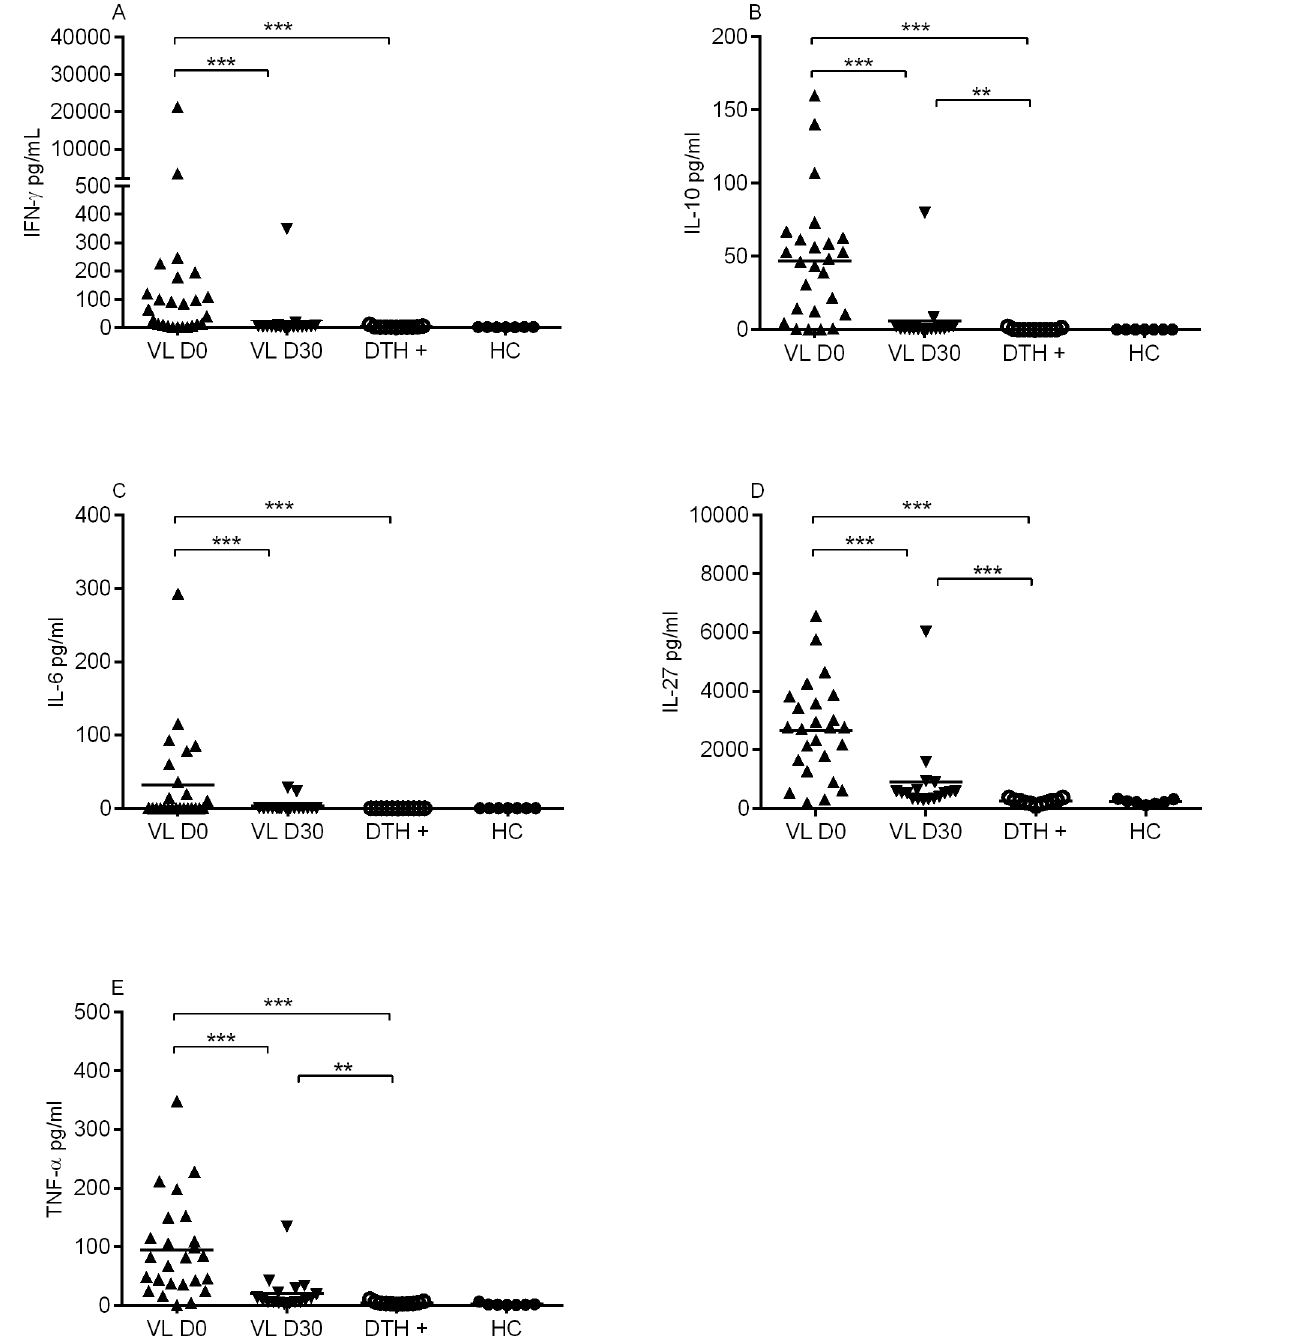
Fig 1. Serum levels of cytokines. Cytokines were measured by Luminex assay in sera of VL patients before (n = 25) and after treatment (n = 17) (D0 and D30, respectively), DTH+ (n = 11) and healthy control (n = 7). (A) IFN- γ (B) IL-10, (C) IL-6, (D) IL-27 and (E) TNF- α .